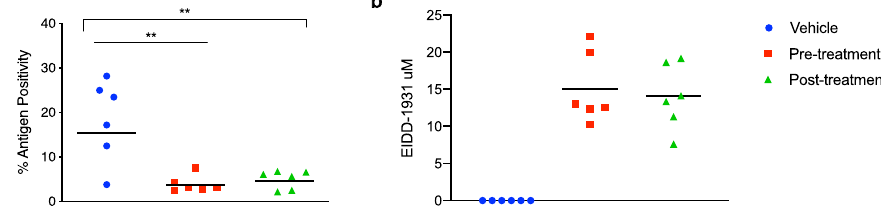
Fig. 4 Morphometric analysis of viral antigen and drug concentration in the lungs. a A longitudinal cross section of the right lung of each animal ( N = 6 per group) was stained for viral antigen and scanned to measure the total amount of viral antigen present in the lung section. b EIDD-1931 concentrations in the lungs. a , b Blue circle, vehicle control; red square, pre-infection treatment; green triangle, post-infection treatment. Summary of results. a The area of lung staining positive for viral antigen showed a statistically signi fi cant difference between both of the MK-4482 treatment groups, compared to vehicle controls. No difference between individual treatment groups was present. (One-way ANOVA followed by Kruskal – Wallis analysis and a pairwise Wilcox test was used to analyze differences among groups. ** p < 0.008).